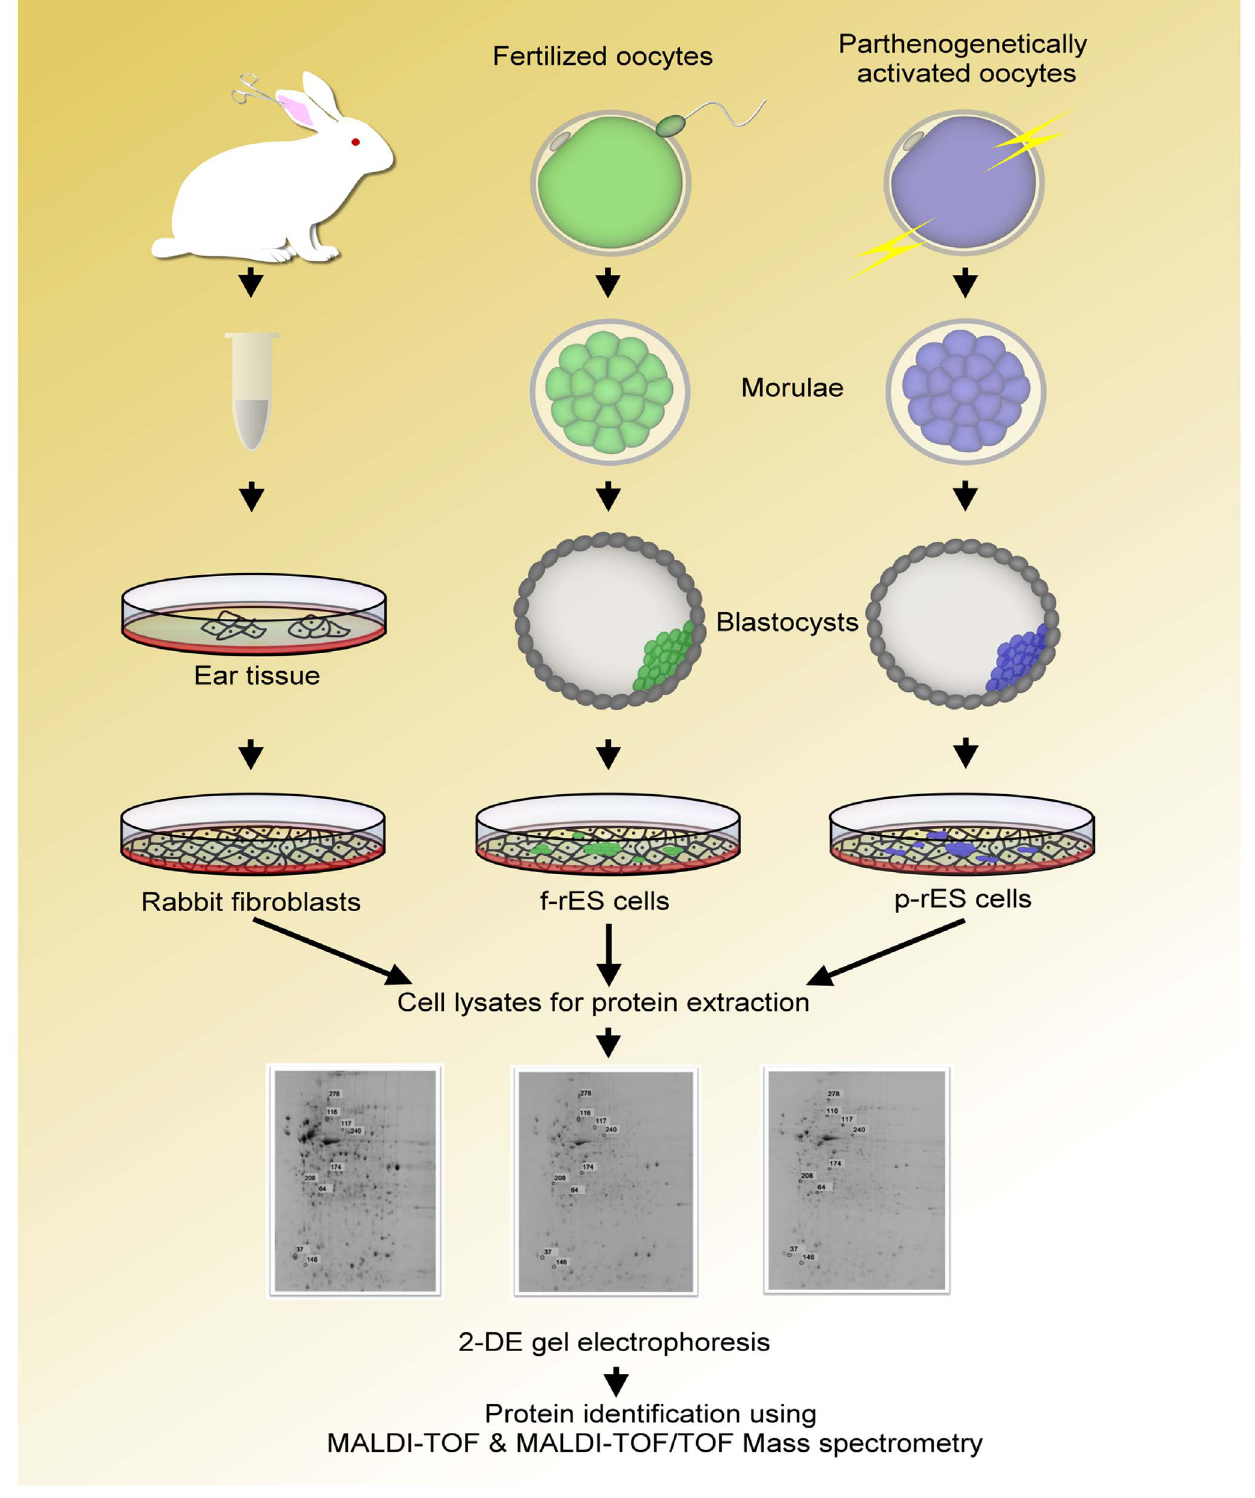
Figure 1. The schematic diagram shows the experimental procedures of the 2-DE-based proteomic analysis in this study. Three rabbit cell types (fibroblast, f-rES, and p-rES cells) were used for soluble protein extraction and analysis. The expression levels of protein spots were compared among all cell types.